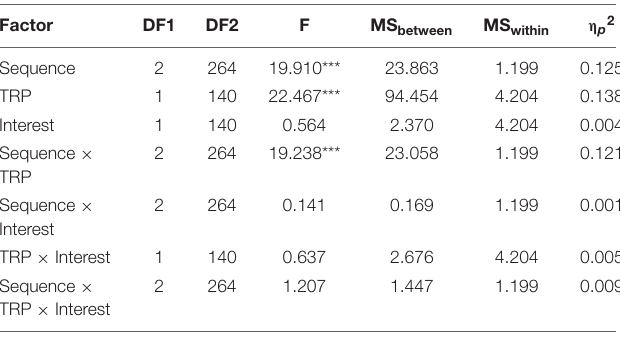
TABLE 3 | ANOVA results for price